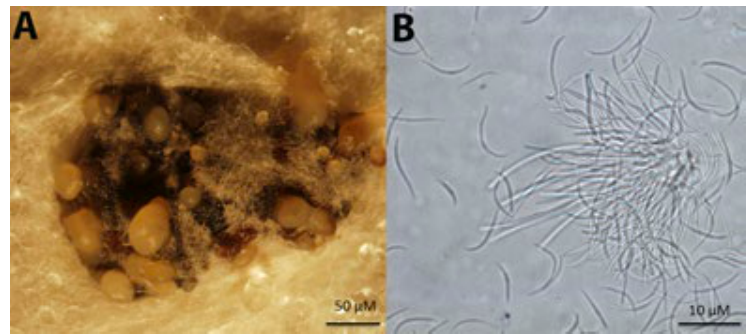
Figure 2. Eutypella microtheca pycnidia (A) and masses of conidia (B), grown on PDA at 28 °C, during 45 d with 12 h cycles of fluo - rescent light.